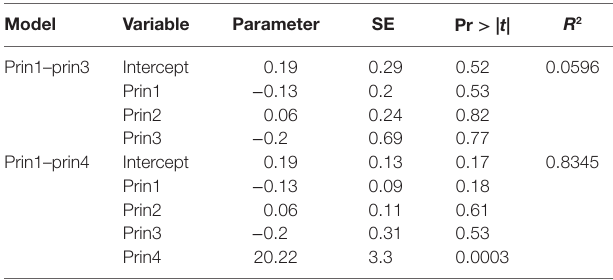
TABLe 6 | Regression analysis by PCA